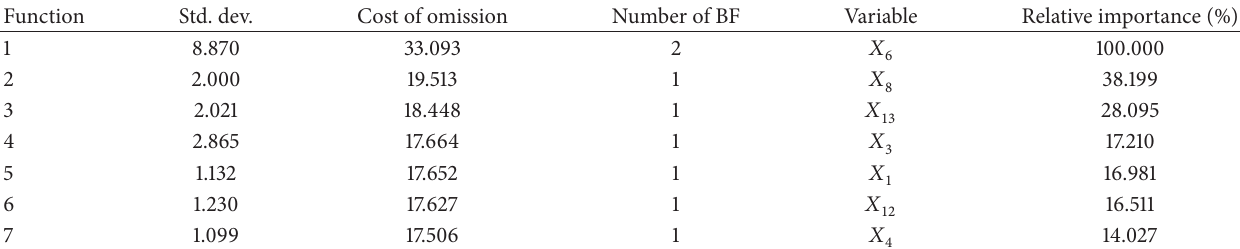
Table 5: Basis functions and important explanatory variables for the MARS model. Function